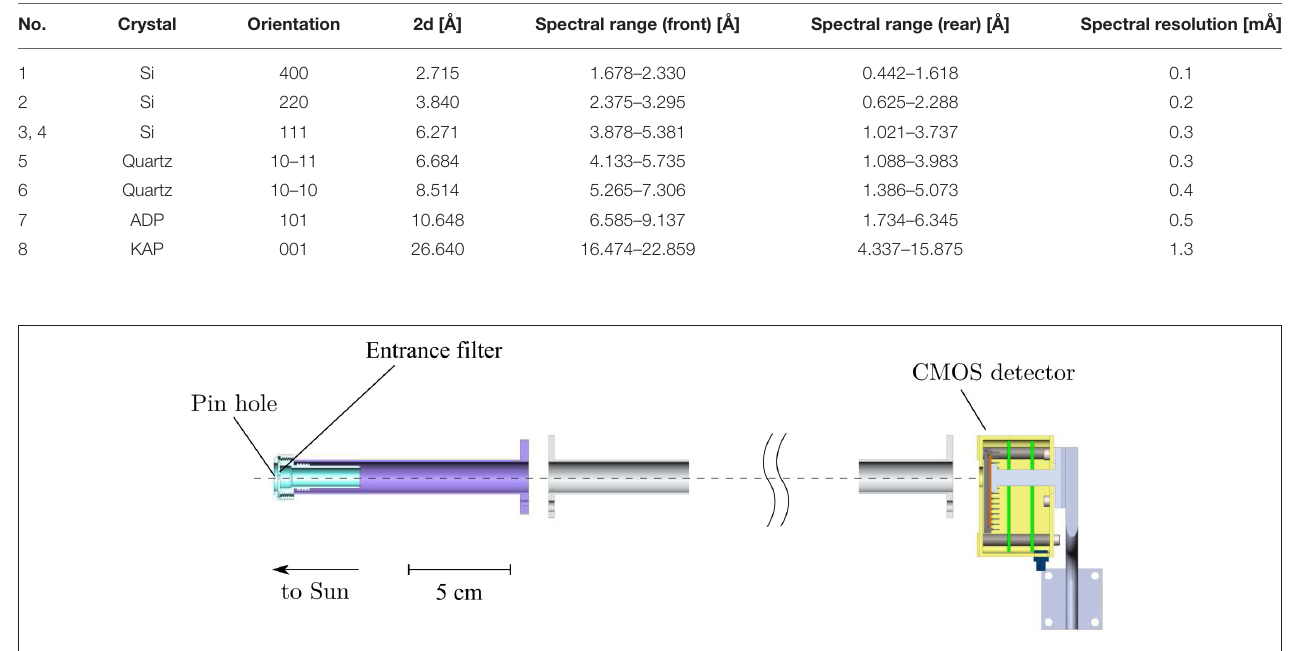
FIGURE 6 | A cross sectional view of the Pin-Hole Imager (PHI) inside the KORTES-SU assembly. The solar disk is projected onto a CMOS sensor placed 70 cm behind a 0.7 mm pin hole.